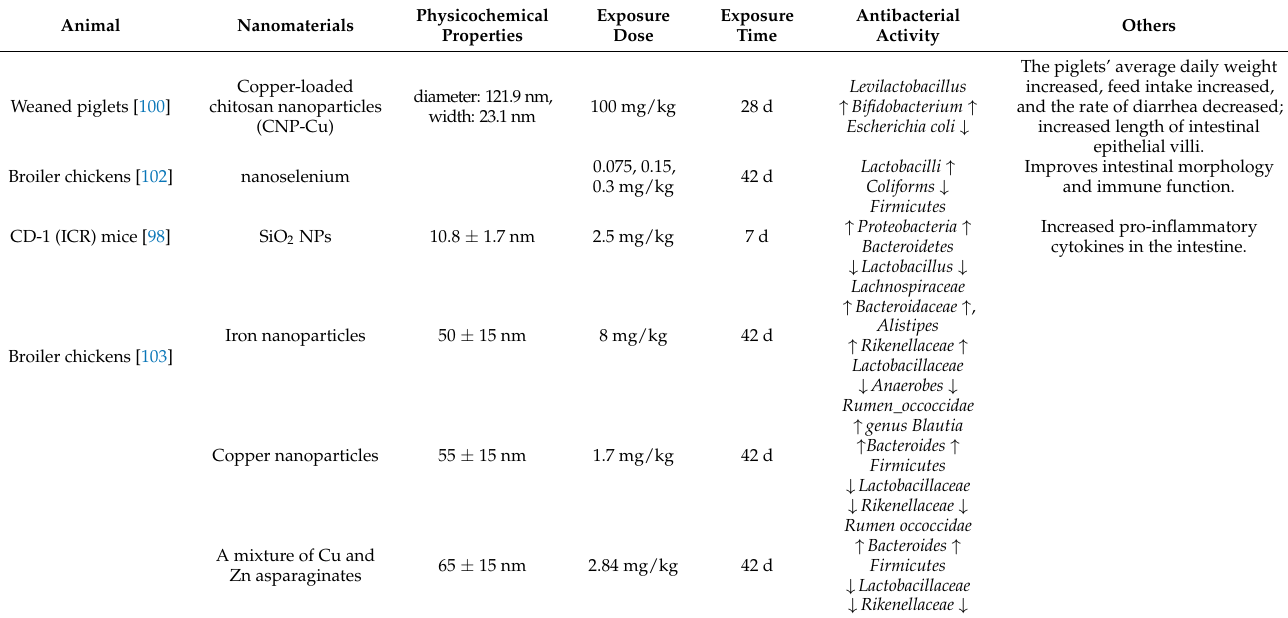
Table 5. Effects of other nanomaterials on gut